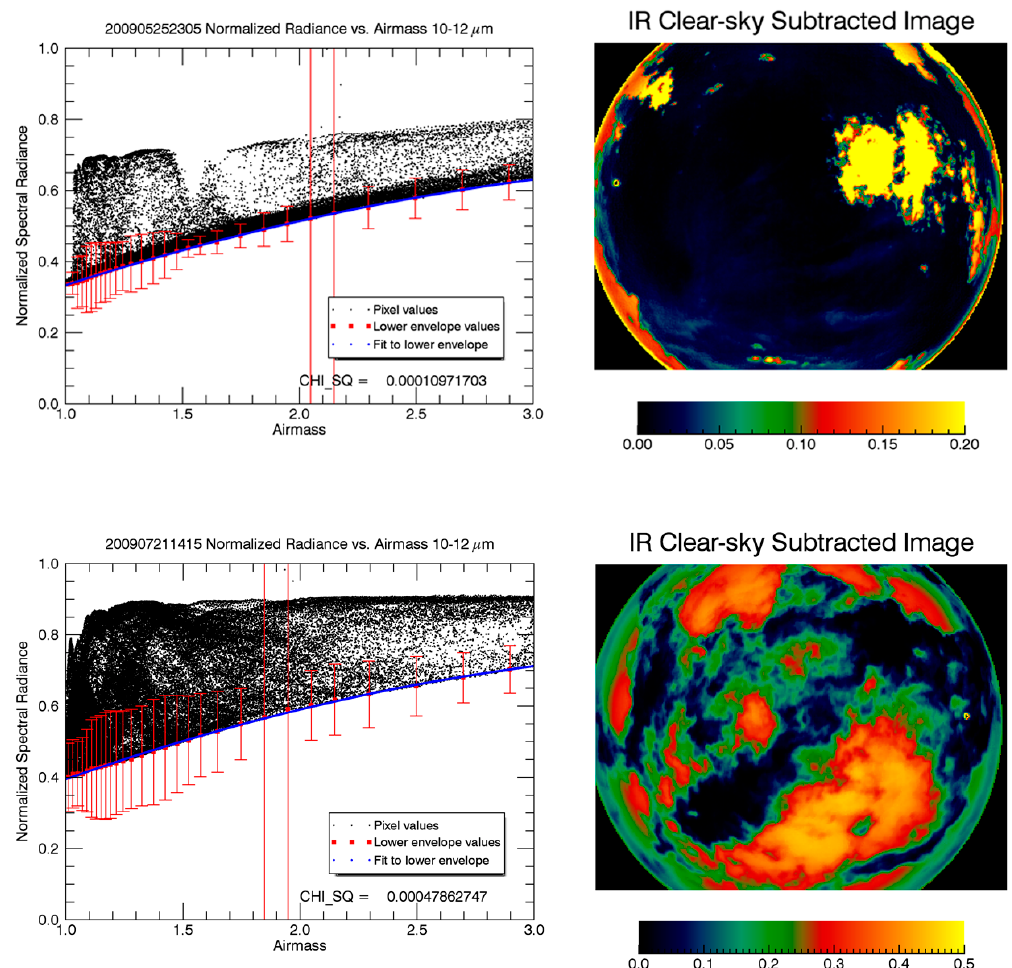
Fig. 6. Pixel normalized radiance vs. airmass data (left) on 25 May 2009 at 23:07UTC (top) and 21 July 2009 at 14:17UTC (bottom). Blue line represents 2nd-order polynomial fit to lower envelope of points (red squares) in each of 29 airmass bins. Clear-sky subtracted images derived from this analysis (right). Note: image is truncated at 6 airmasses. Large error bars (near 2 airmasses) are due to the Sun’s extreme pixel values at this